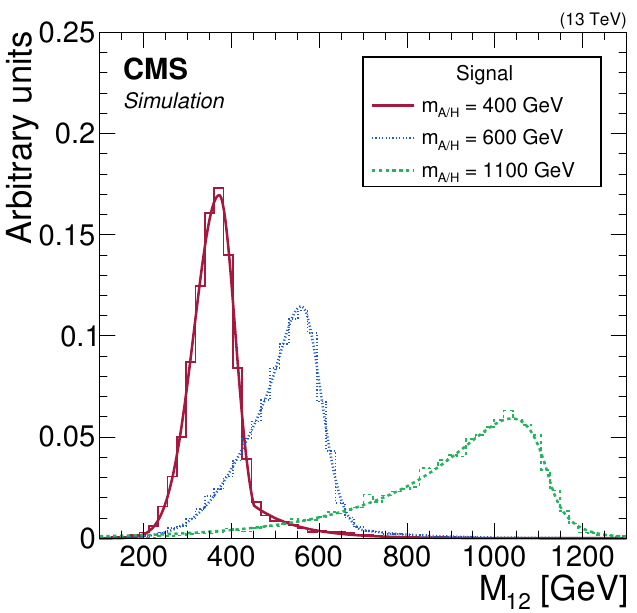
Figure 3 . Invariant mass distributions of the two leading b jets in simulated signal events and their parameterizations for three di(cid:11)erent A/H masses, normalized to